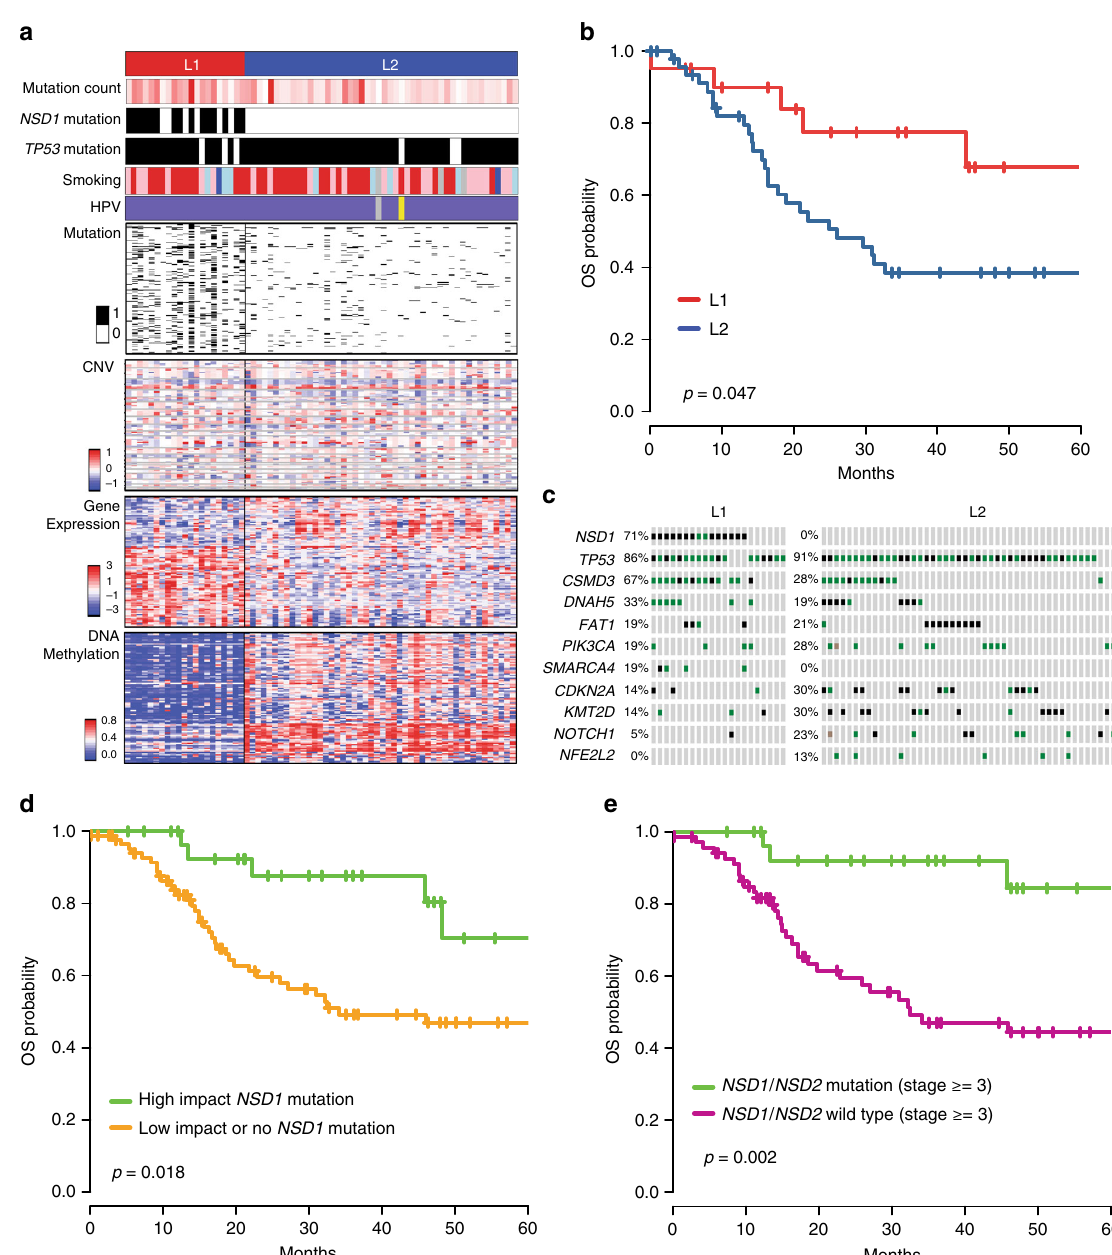
Fig. 2 Integrative clustering of 69 laryngeal tumors. a The top panel shows larynx L1 (red) and L2 (blue) clusters. Mutation count for each sample is provided as a color gradient. NSD1 and TP53 bars indicate mutations in these genes (black). Smoking status (red = current smoker; pink = former smoker < 15 years; cyan = former smoker > 15 years; blue = lifelong nonsmoker; gray = status unavailable) and HPV status (purple = HPV – ; yellow = HPV +; gray = unknown) are indicated. Also see Fig. 1 Legend and Methods. b Kaplan – Meier curves depicting OS of L1 and L2 clusters ( p -value from log-rank test). c Mutation grid map of genes commonly mutated in L1 and L2. Each vertical bar represents a patient; black dot = truncating mutation; green = missense mutation. d KM curves for 116 laryngeal samples with NSD1 mutation impact determined by MutationAssessor 39 , Polyphen, and other function prediction algorithms. e KM curves for higher-stage laryngeal tumors (clinical stage 3 and 4) based on the presence or absence of predicted damaging mutations in NSD1 or encoded E6 oncoprotein 2 . The recently described prognostic 3pdel/TP53 subclass 12 (Supplementary Fig. 1) is common in all HPV – clusters except cluster 2 (6%). Most laryngeal tumors segregated to clusters 3 (25%) and 4 (39%), with the remaining 36% distributed evenly across the other clusters. SCCHN tumors in cluster 3 were associated with signi fi cantly higher OS vs. those in cluster 4 (2-year OS: 81.6% (95% CI 63.3 – 91.3%) vs. 54.6% (95% CI 37.9 – 68.5%); log-rank test: p = 0.001; Fig. 1c). This marked survival difference between